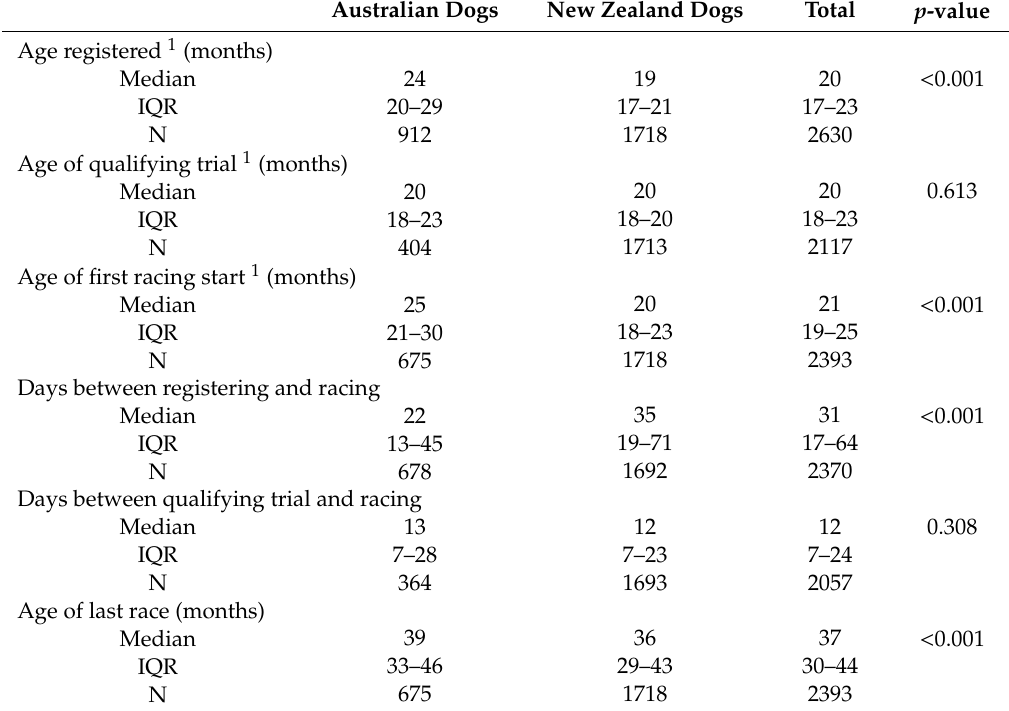
Table 2. Summary information for the age at which racing milestones were reached, as well as the time between registering, trialling and racing, for a cohort of New Zealand greyhounds that raced during the 2013–2016 racing seasons. Di ff erences between dogs from the two countries were tested with a Kruskal–Wallis test. IQR: inter-quartile